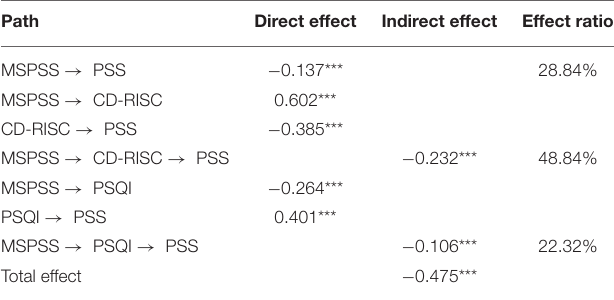
TABLE 3 | Path analysis of social support, stress perception, sleep quality, and psychological resilience of respondents.